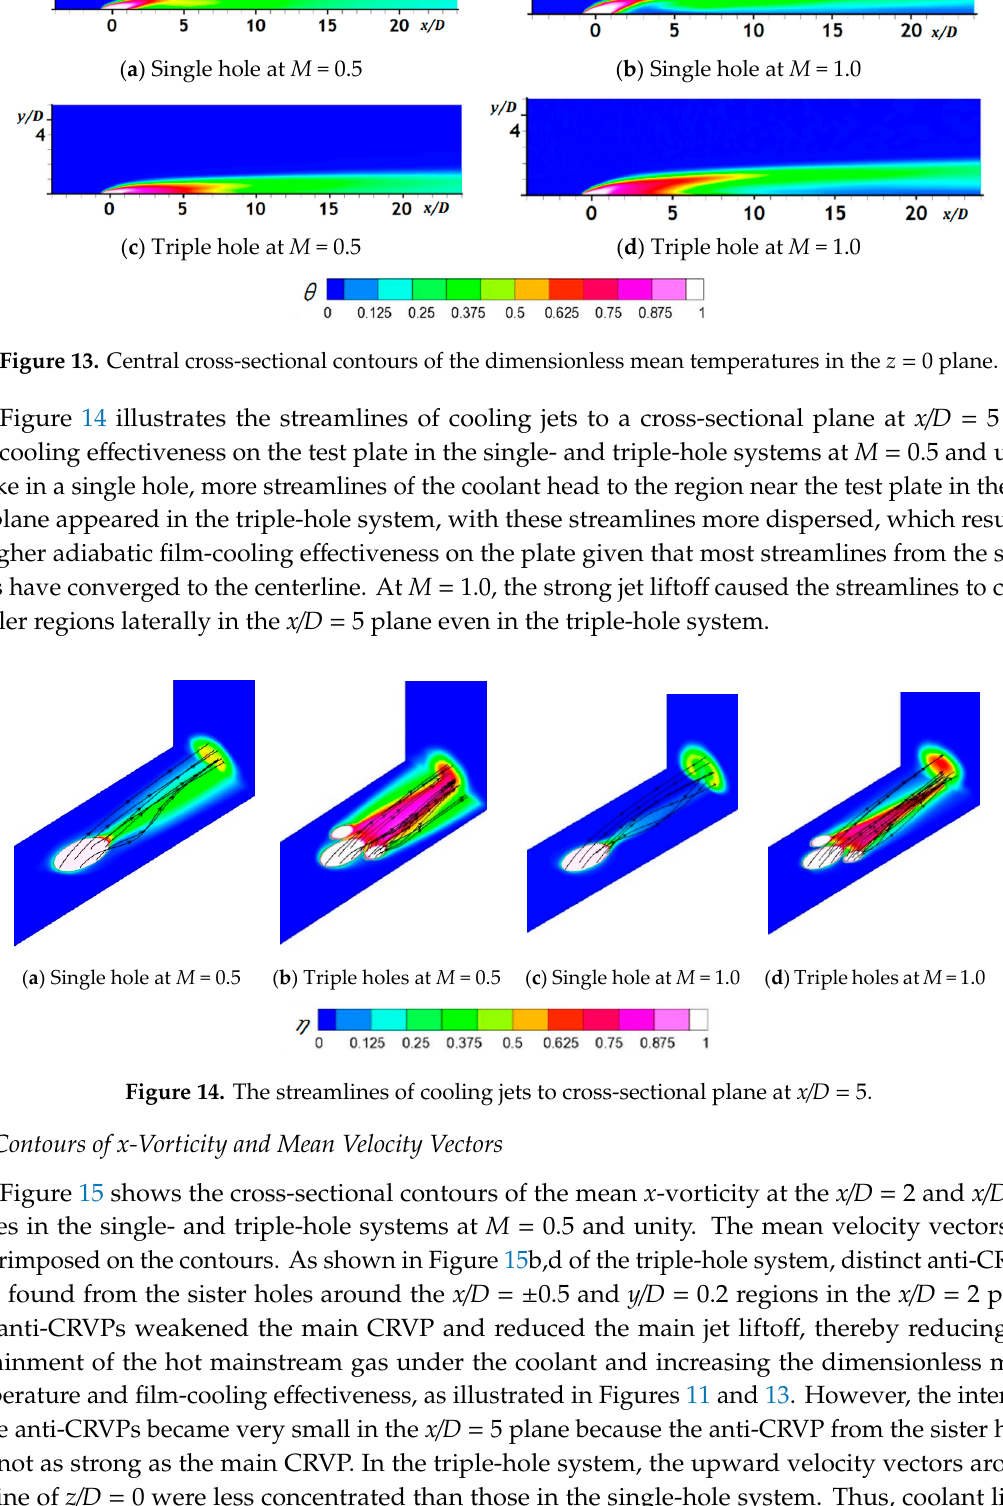
Figure 14. The streamlines of cooling jets to cross-sectional plane at x/D = 5.